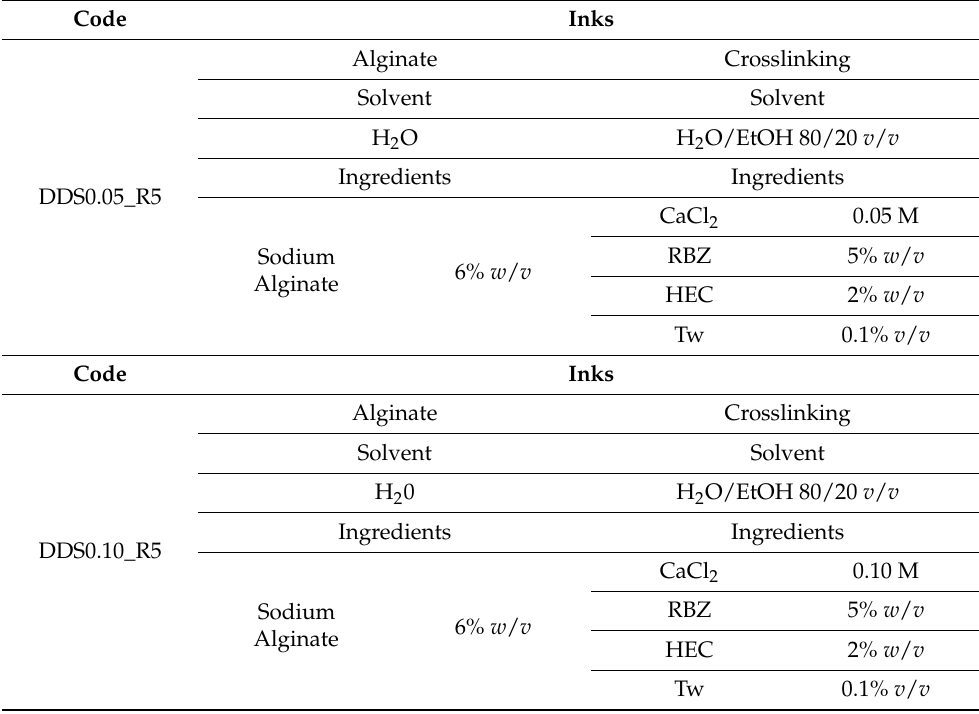
Table 3. Composition of both alginate and crosslinking